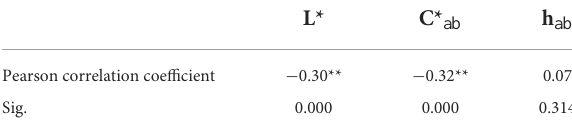
TABLE 1 Perception experiment scoring rules. TABLE 2 Pearson correlation between 1 E * and L * , C *